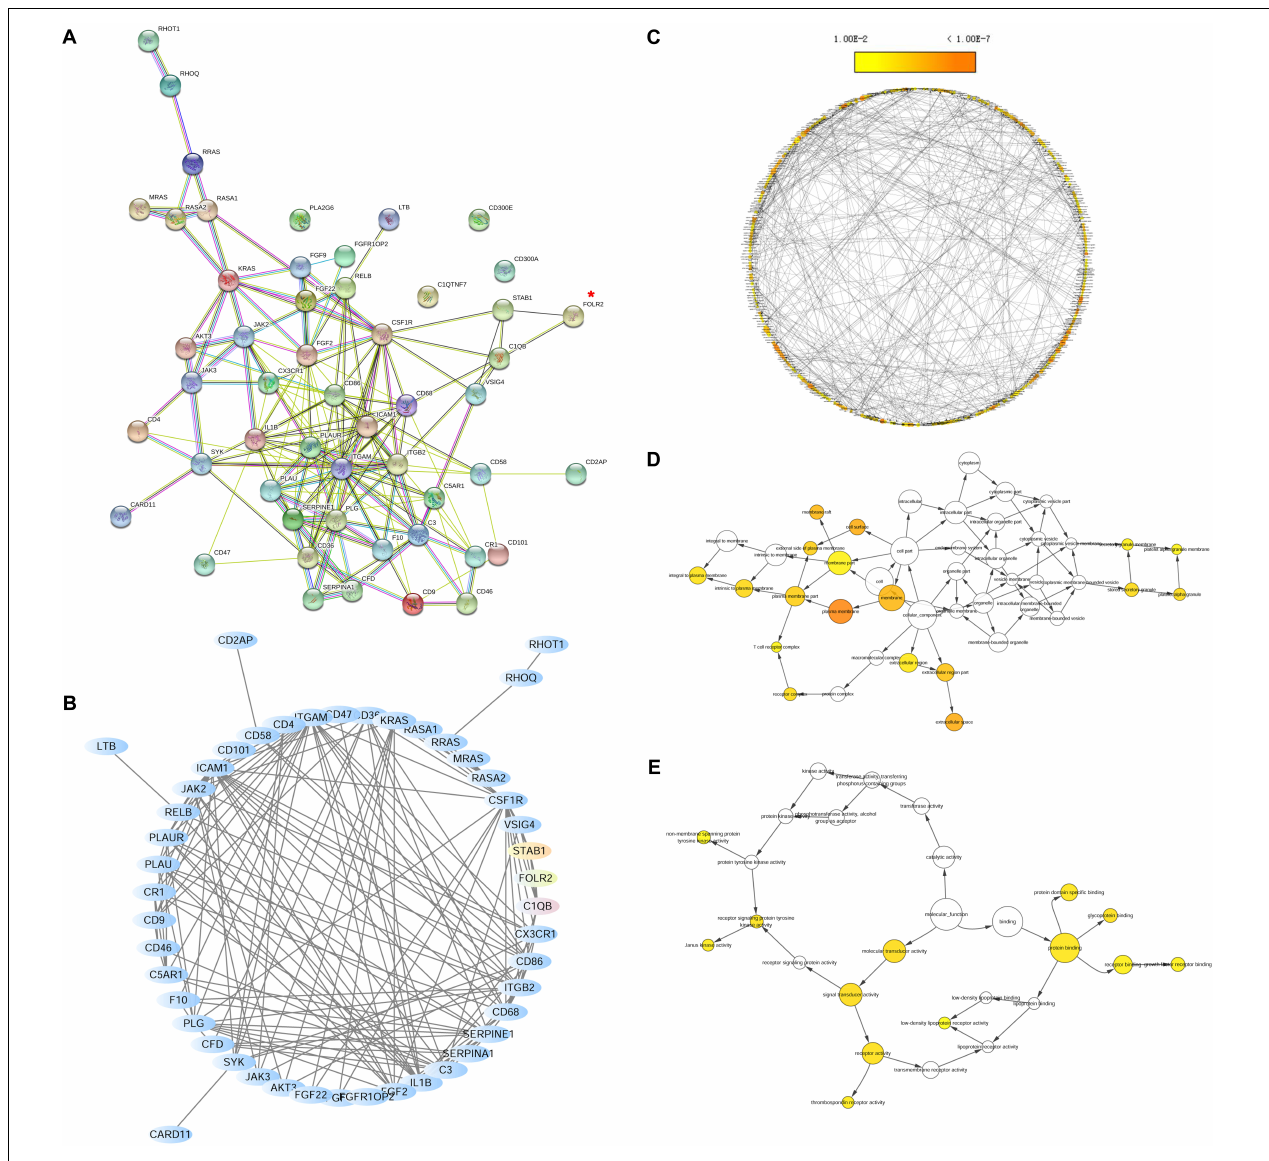
FIGURE 6 | The network analysis of the biological interactions within DEGs based on the RNA-seq datasets. (A) The PPI network of DEGs related to immune responses. The network nodes represent proteins and the edges represent protein-protein associations. The position of FOLR2 is marked by a red asterisk. (B) The network of DEGs related to immune responses using Cytoscape. The first neighbors of FOLR2 (red) were STAB1 (yellow) and C1QB (green). (C) Representative biological process based on BiNGO. (D) Representative cellular component based on BiNGO. (E) Representative molecular function based on BiNGO. Orange categories are most significantly overrepresented and white nodes are not significantly overrepresented. The area of a node was proportional to the number of DEGs in the test